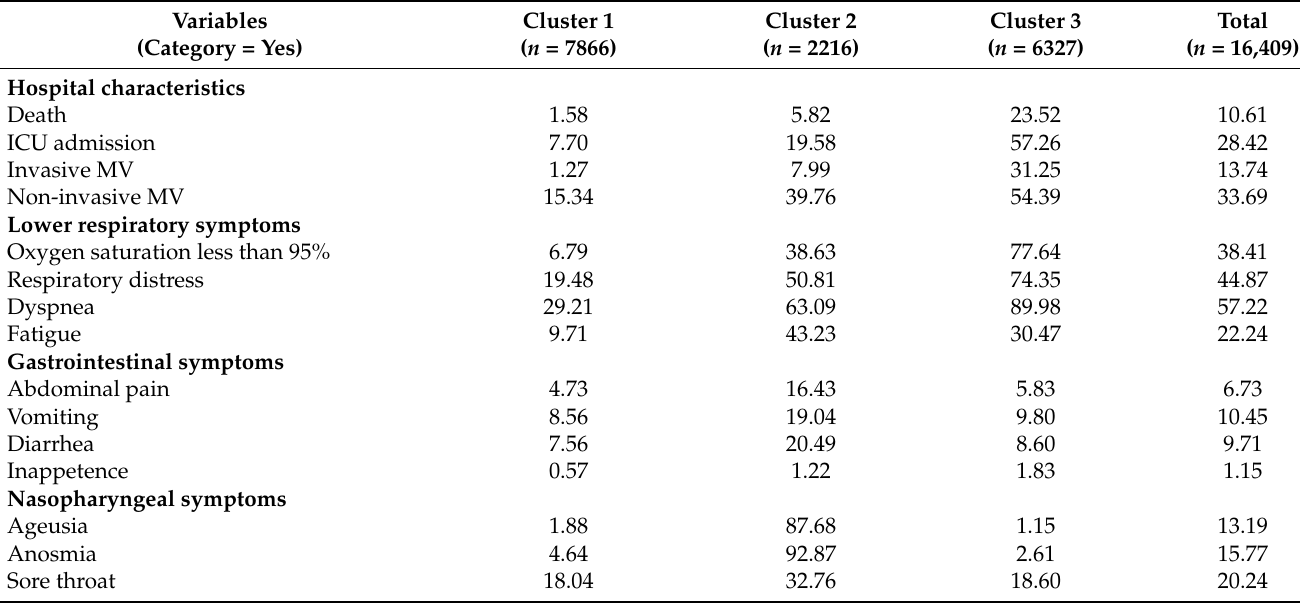
Figure 2. Distribution of the pregnant and postpartum women with SARS due to COVID-19 into the three clusters according to the first and the second principal component (PC). Table 2. Relative frequency of symptoms, comorbidities, hospital, demographic, and obstetric characteristics per cluster and in the total population of pregnant or postpartum women with SARS due to